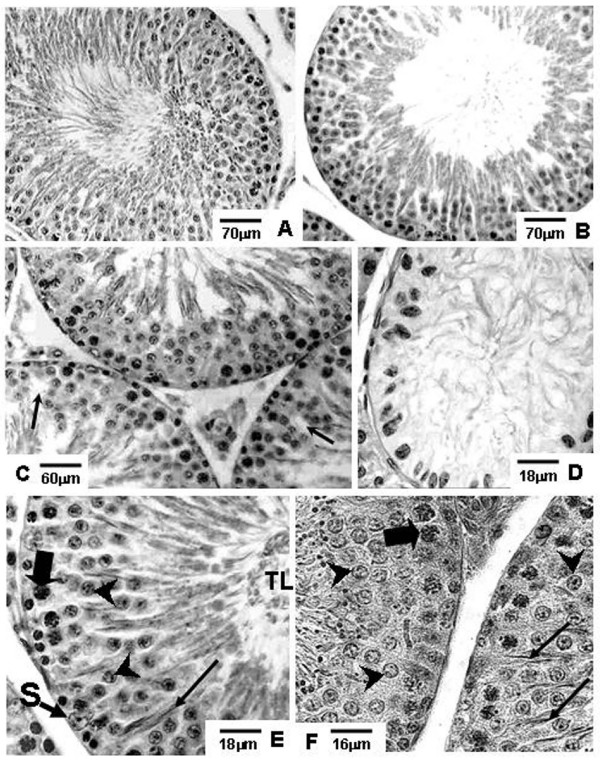
Photomicrographs of testicular sections of Sham Control, Amifostine, Doxorubicin and Amifostine/Doxorubicin treated rats at different ages. PAS+H method. Portions of seminiferous tubule sections of 90-day-old rats. A and B: Sham Control (A) and Amifostine (B) groups showing normal organization of the seminiferous epithelium. C and D: Doxorubicin-treated group; in C, tubular sections with partial depletion of the seminiferous epithelium are noted; some areas of discontinuity in the germ cell layers can be observed (arrows); in D, a tubular section with accentuated cellular depletion and showing Sertolization is shown. E and F: Amifostine/Doxorubicin-treated group; in both figures, note the concentric and normally organized germ cell layers of the seminiferous epithelium; pachytene spermatocytes (thick arrows); Sertoli cell nucleus (S); round spermatids (arrowheads); elongated spermatids (long arrows); tubular lumen (TL).